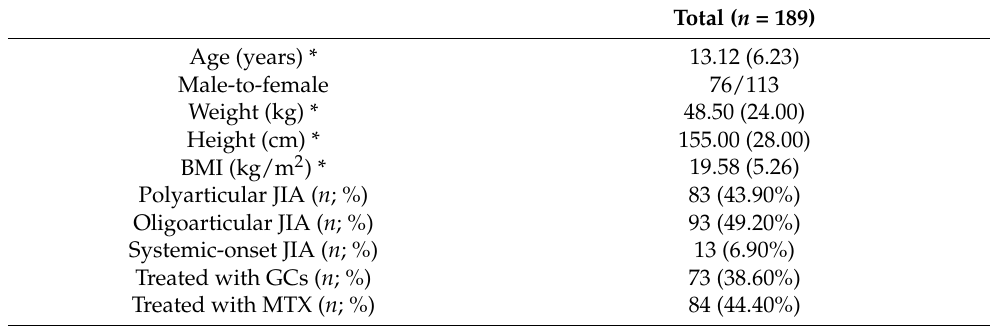
Table 1. Basic characteristics of the study group (* Median and IQR value are shown when